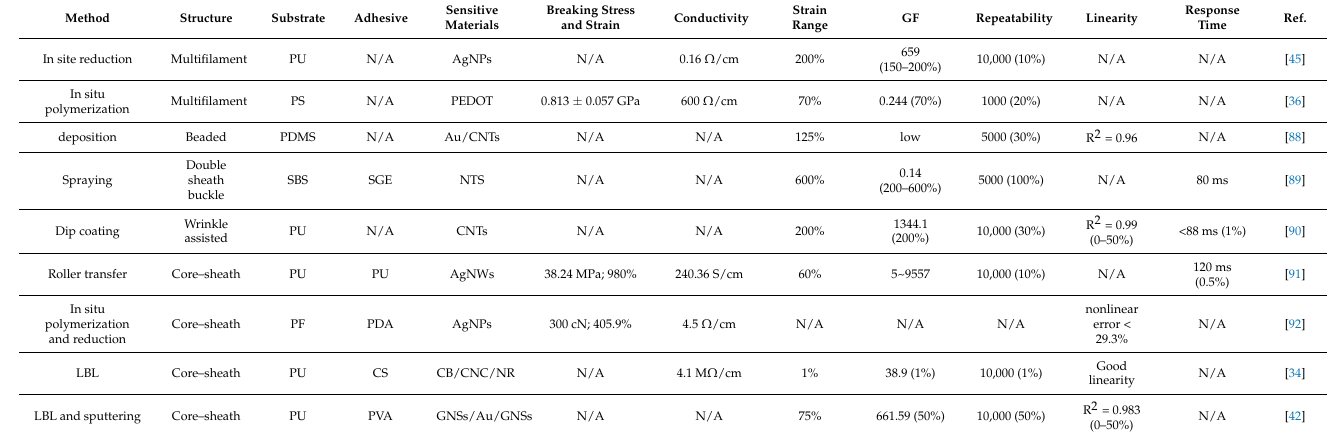
Table 5. Characteristics of fiber strain sensors prepared by coating